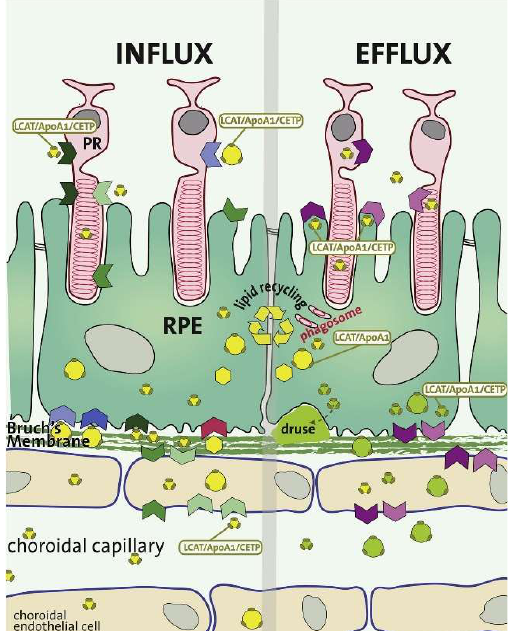
Figure 1. The metabolic flux of various lipids and their associated proteins in the retinal pigment epithelium (RPE). In addition to anabolic and catabolic lipid metabolism, the RPE also functions as a transfer site for lipids and proteins (yellow and green spheres) between the circulation and the photoreceptors. The influx of lipids from the RPE to the photoreceptors is represented on the left side, whilst the efflux of lipids is represented on the right side of the image. There is substantial recycling of lipids by the RPE, which are continuously provided through the phagocytosed membrane discs of photoreceptor outer segments (POS). The oxidized lipid species either enter the circulation as lipoprotein particles (green spheres) or are basally deposited into the sub-RPE space leading to the formation of drusen. LCAT, lecithin-cholesterol acyltransferase; APOA1, apolipoprotein A1; CETP, cholesteryl ester transfer protein. Colored arrows represent lipid receptors and their direction of transport. Reproduced with permission from van Leeuwen et al. [18].